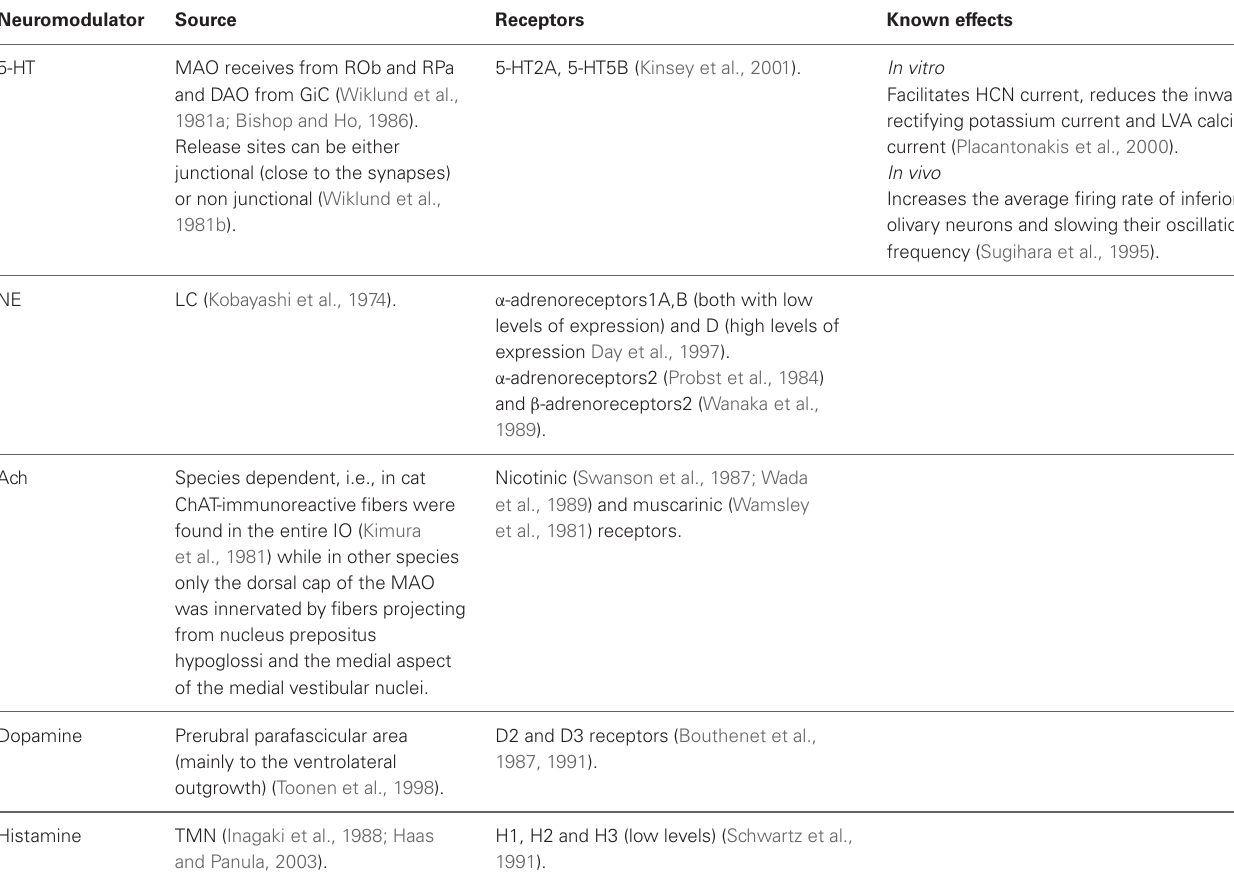
Table 3 | Neuromodulators of the inferior olive.